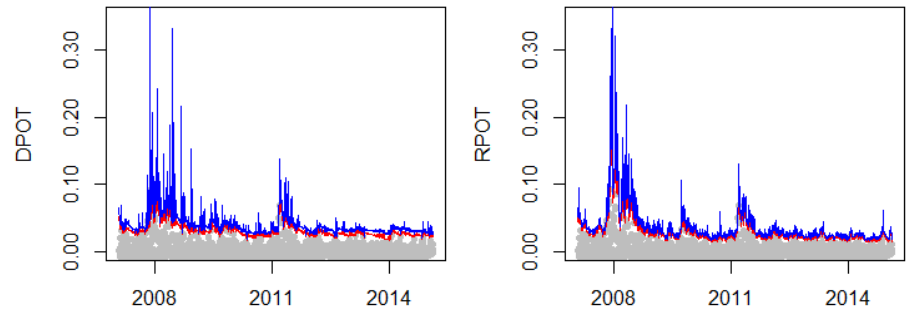
Figure 6. Predicted VaR ( red ) and ES ( blue ) at the α = 0.01 level for the DPOT and RPOT models, and losses of the validation sample ( grey ). Table 3. p -values of the UC, IND and CC tests of Christoffersen (1998) on the VaR predictions, and